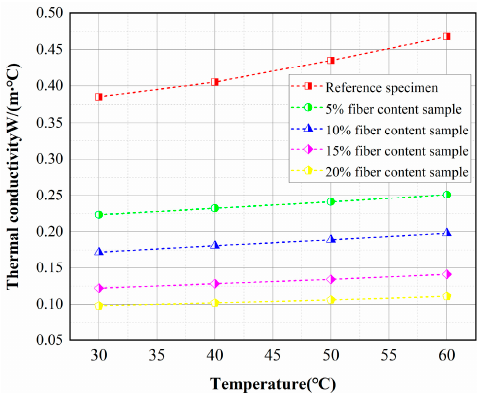
Figure 12. Effect of temperature on the thermal conductivity of insulating concrete.